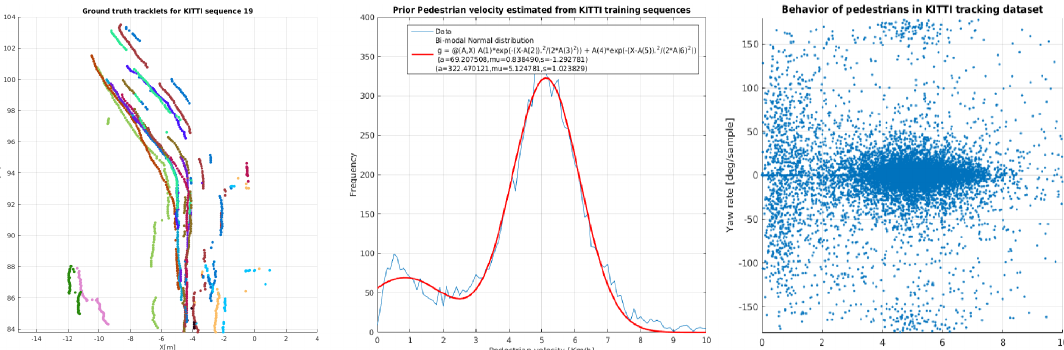
Figure 4. Example of the ground truth data used to model our behavioral motion priors. Left : ground truth tracklets from the 0019 tracking sequence in the KITTI tracking dataset. Middle : Estimated prior probability distribution of walking pace. Right : Measurements of yaw rate relative to the walking